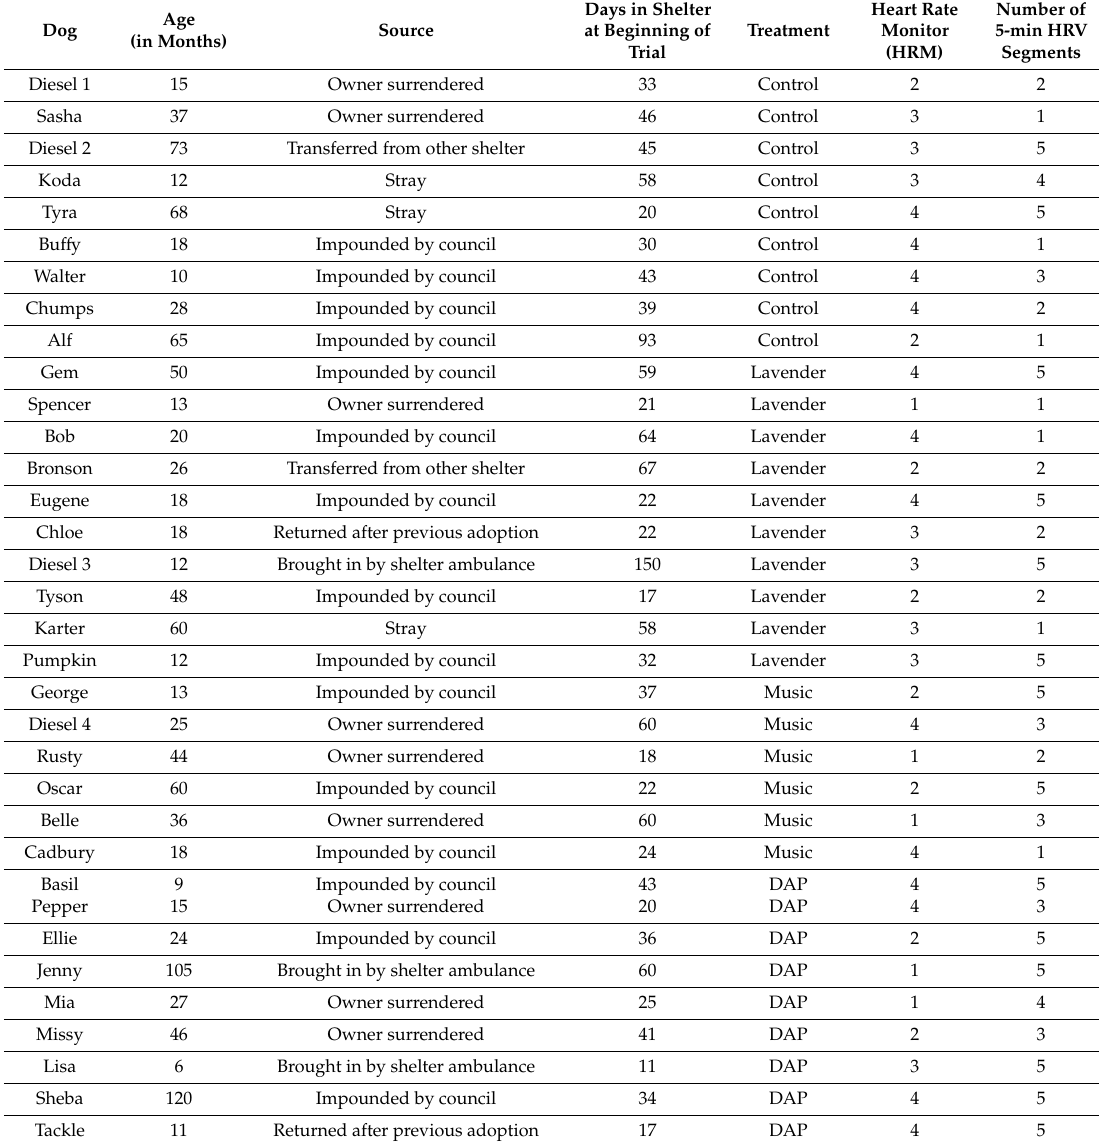
Table A1. Dogs ( n = 34) included in the HRV